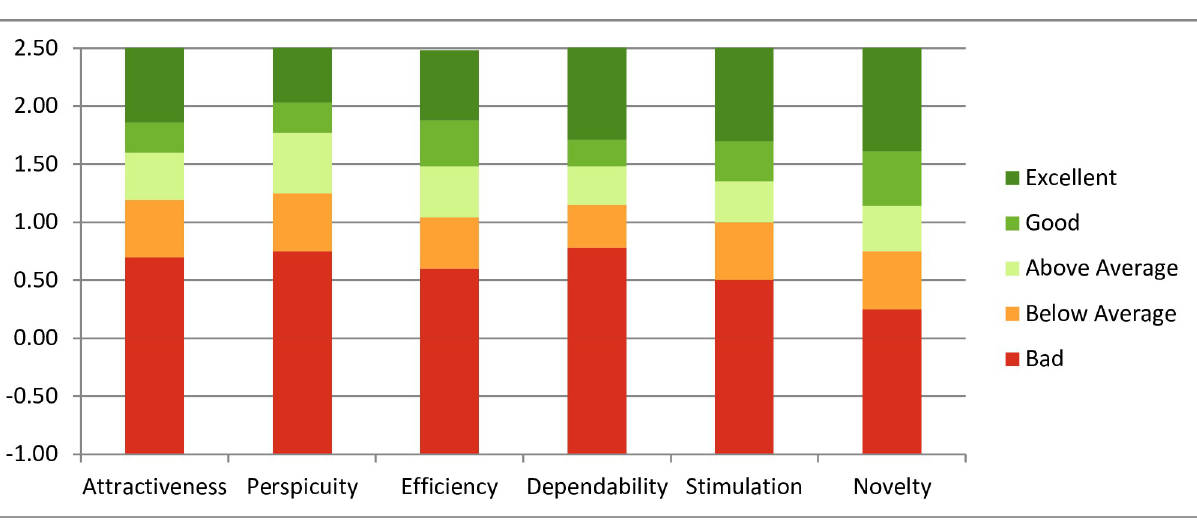
Fig 5. Quality benchmark graph for Project OPUS training